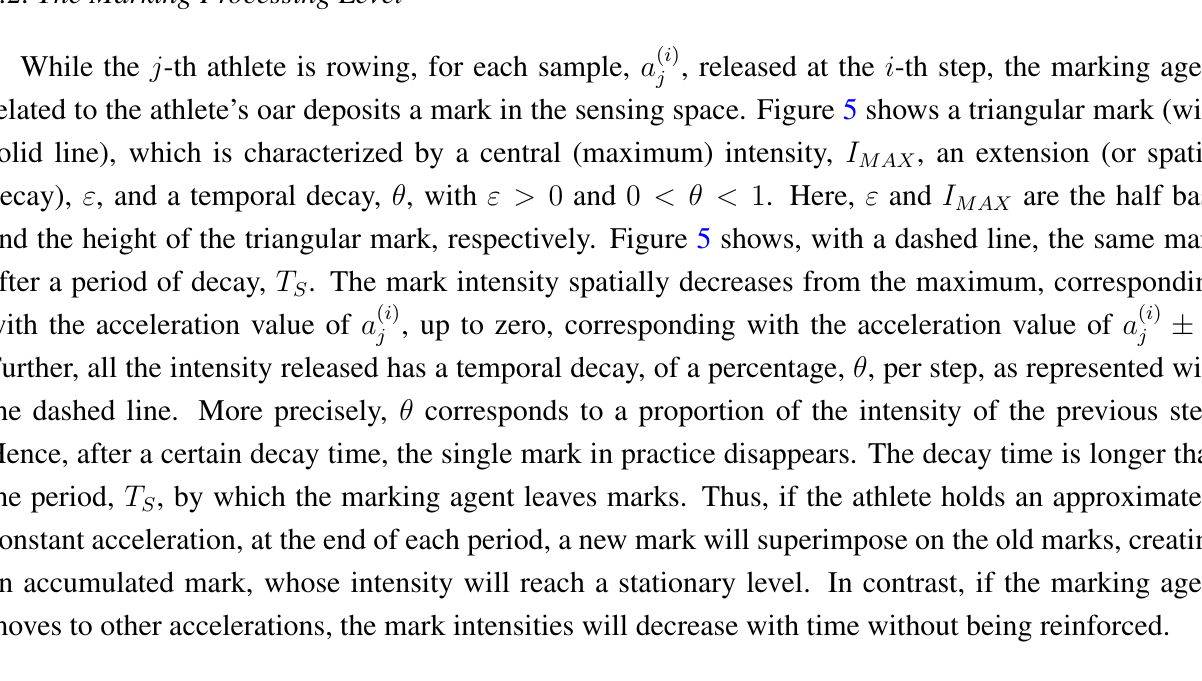
Figure 5. A single triangular mark released in the sensing space by a marking agent (solid line), together with the same mark after a step of decay (dashed